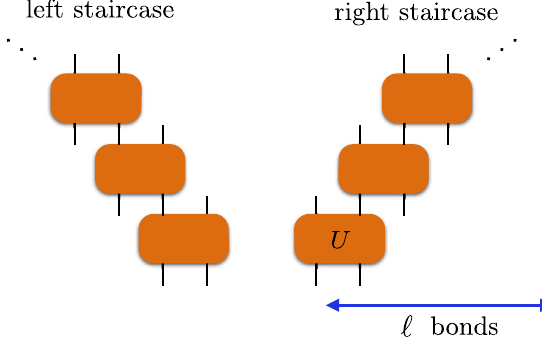
FIG. 18. Random circuit built from “ staircase ” unitaries: We use “ left ” and “ right ” staircases — built from random two-site unitary operators as shown, and extending over l bonds — as the building blocks for a random quantum circuit in which the ratio of the entanglement and butterfly velocities v arbitrarily